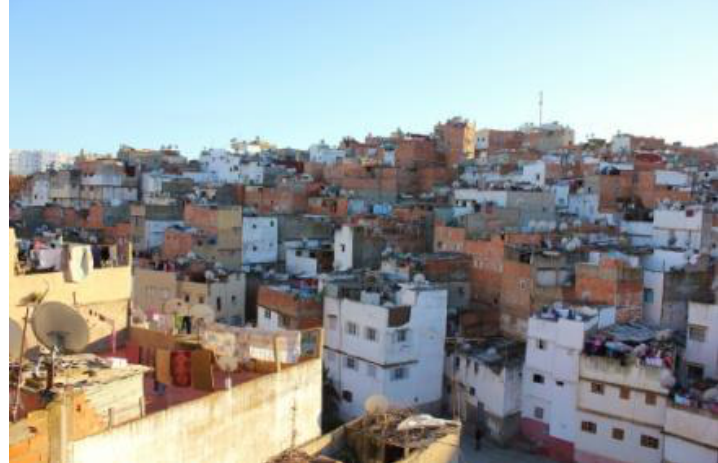
Figure 4: Youssoufia